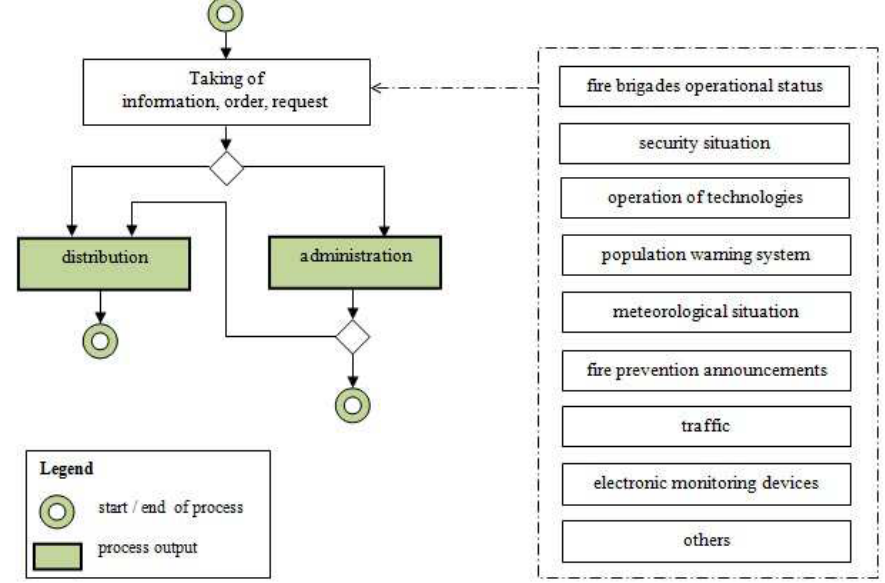
Figure 4 - Security situation monitoring – the process